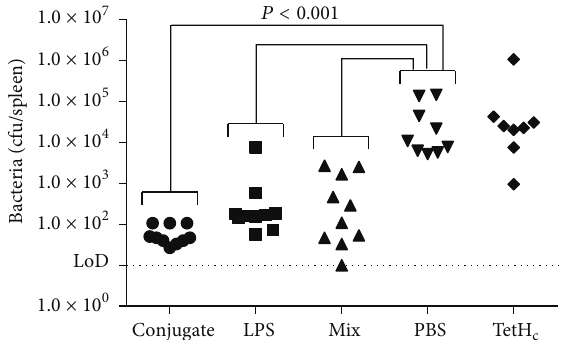
Figure 4: The bacterial burdens of spleens 48 hours after infection. Mice were vaccinated three times at two-week intervals with 10 𝜇 g of either the TetH c -LPS conjugate ( ∙ ), LPS alone ( ◼ ), a mix of unconjugated LPS and TetH c ( 󳵳 ), TetH c only ( ⧫ ), or PBS ( 󳶃 ) and challenged five weeks after the final vaccination with approximately 40 MLD of B. pseudomallei K96243. Forty-eight hours after challenge, mice were culled and spleens were removed and assayed for bacterial burden. Data is shown for replicate studies and was analysed by univariate linear model. Significant differences are shown. Where no markers are present, 𝑃 was greater than 0.05.